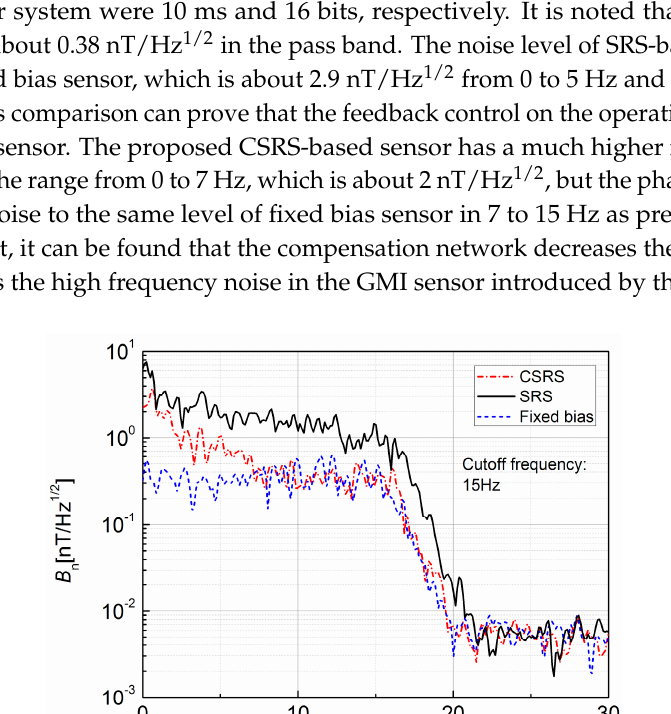
Figure 12. Photograph of the developed GMI sensor. 4. Conclusions A GMI magnetic sensor based on the operating point self-regulator is developed in this work. The operating point self-regulator is based on a GMR sensor combined with a feedback control network. This regulator can maintain the operating point of GMI sensor on a uniform position regardless of the external magnetic field. In comparison with the former work, we have taken the noise and disturbances introduced into the GMI sensor by the operating point regulator into consideration. As the experiment shows, the developed operating point regulator has a steady-state error of about 2% and step overshoot of 4.2% at the same time. The optimum operating point of the